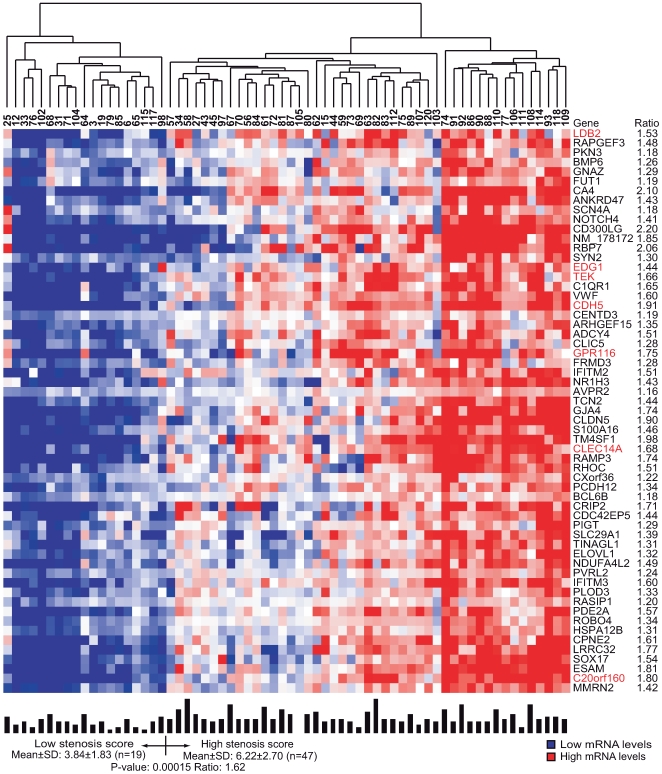
Heat map of a visceral fat cluster related to coronary stenosis.The cluster was defined by related mRNA levels (indicated by average probe signals on the arrays) and identified as one of 20 visceral fat clusters by the second step of coupled two-way clustering of mRNA profiles from STAGE patients (Text S1). Columns represent individual patients, and rows individual RefSeqs with corresponding gene symbols and mRNA ratios of the two patient groups. Above heat map: individual patient numbers, below heat map: bars indicating individual stenosis score together with means ± SD and average ratios in each group and P-values for comparing groups. Red highlighting indicates genes also found in the cluster in Figure 2.